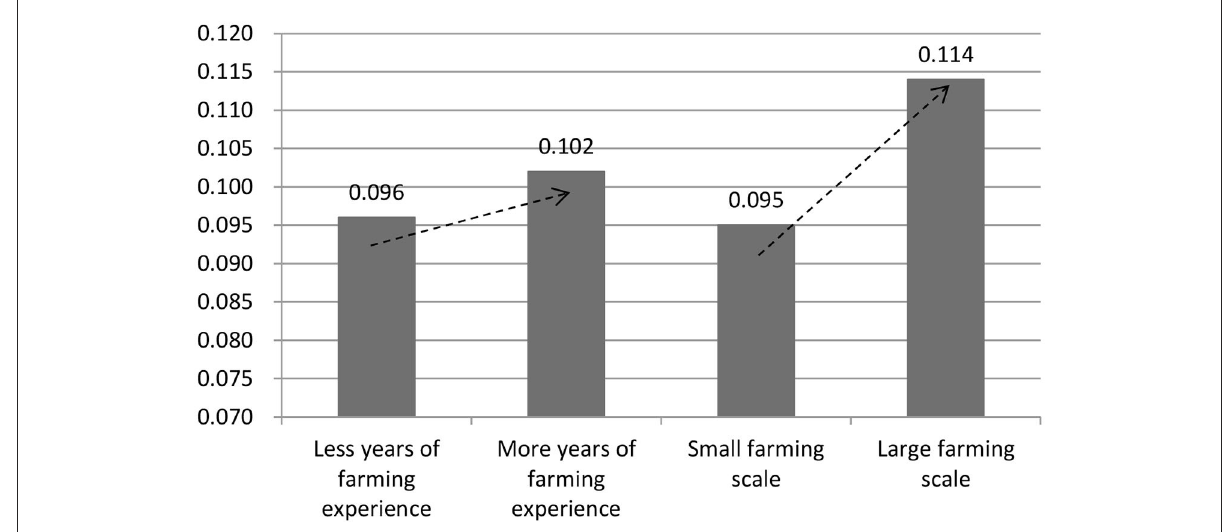
FIGURE3 Broiler mortality and current antibiotic use by an individual